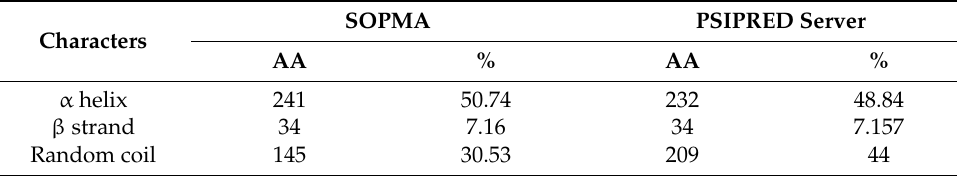
Table 7. The vaccine candidate’s secondary structural